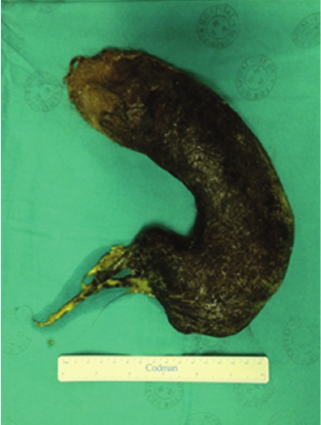
Figure 3: Gastric cast trichobezoar that was removed via gastros-